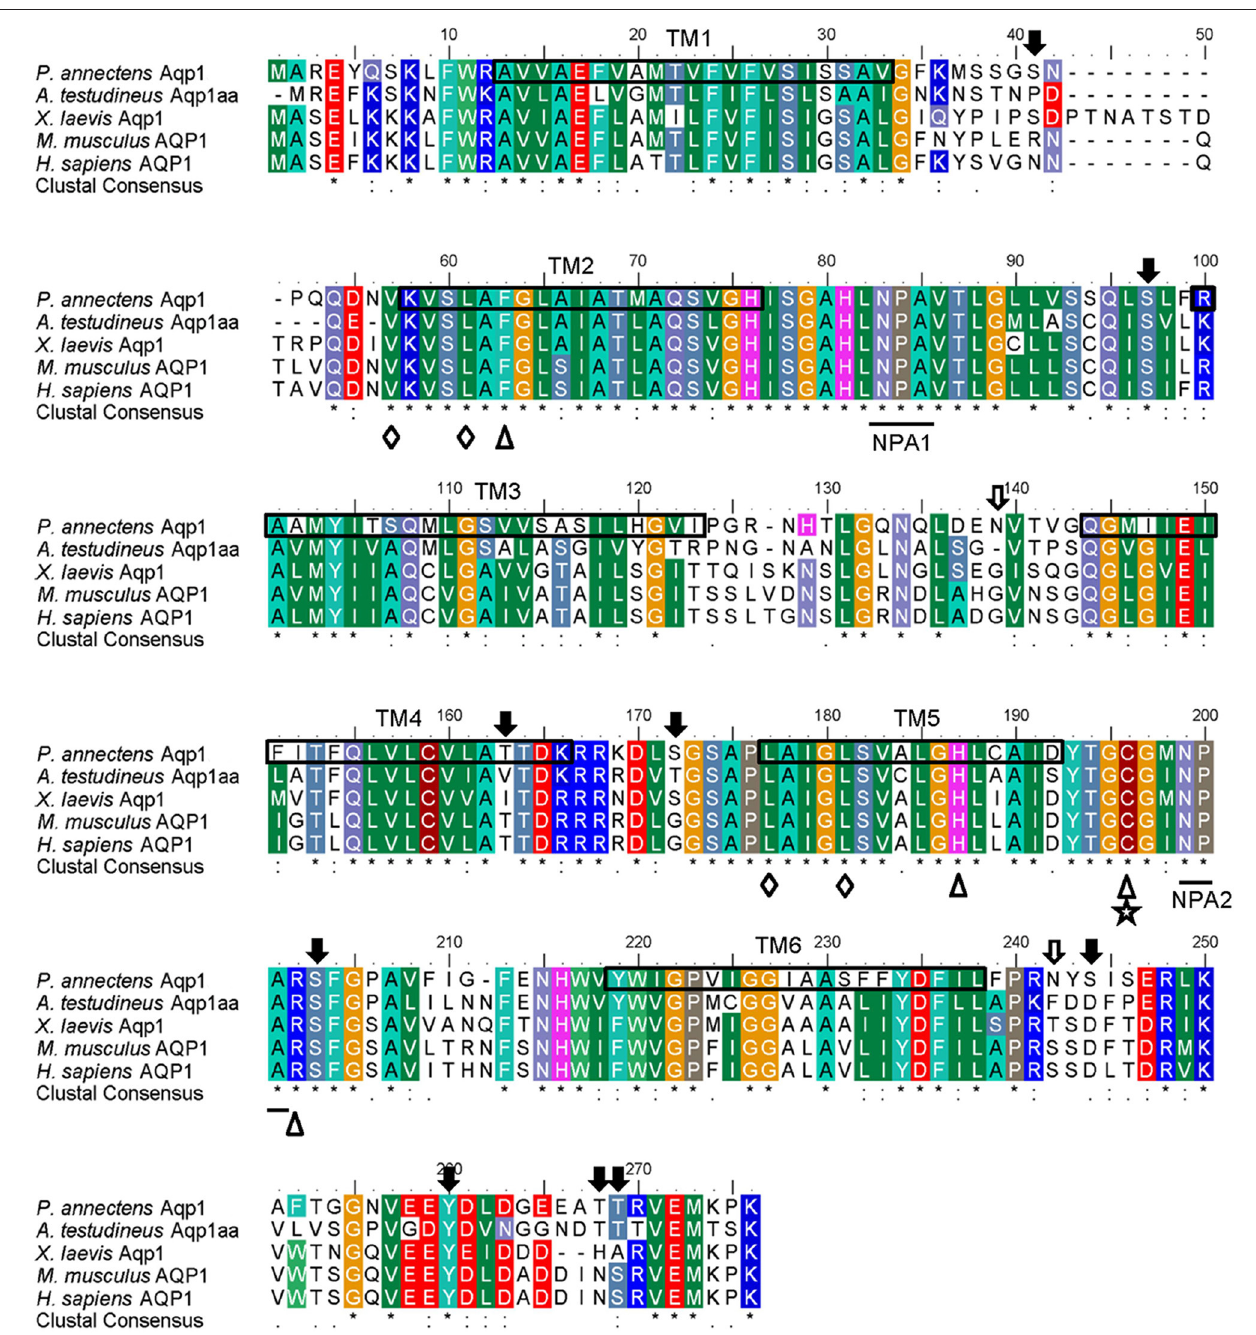
FIGURE 1 | A multiple amino acid alignment of aquaporin 1 (Aqp1) from Protopterus annectens with Anabas testudineus Aqp1aa (AGF30363.1), Xenopus laevis Aqp1 (NP_001085391.1), Mus musculus AQP1 (EDK98728.1), and Homo sapiens AQP1 (CAQ51480.2). Identical amino acid residues are indicated by asterisks, strongly similar amino acids are indicated by colons and weakly similar amino acids are indicated by periods. Substrate discrimination residues at the aromatic/arginine (ar/R) constriction site are indicated with open triangles. Central pore-lining residues are indicated with open diamonds. The binding site for AQP1-inhibitor HgCl 2 is indicated by a five-point star. The asparagine–proline–alanine (NPA) motifs are underlined. Potential N -glycosylation and phosphorylation sites are indicated by open and shaded arrows, respectively. The predicted transmembrane domains (TM1–6) of Aqp1 of P. annectens are indicated by open boxes and were predicted using MEMSATS & MEMSAT-SVA provided by PSIPRED protein structure prediction server.